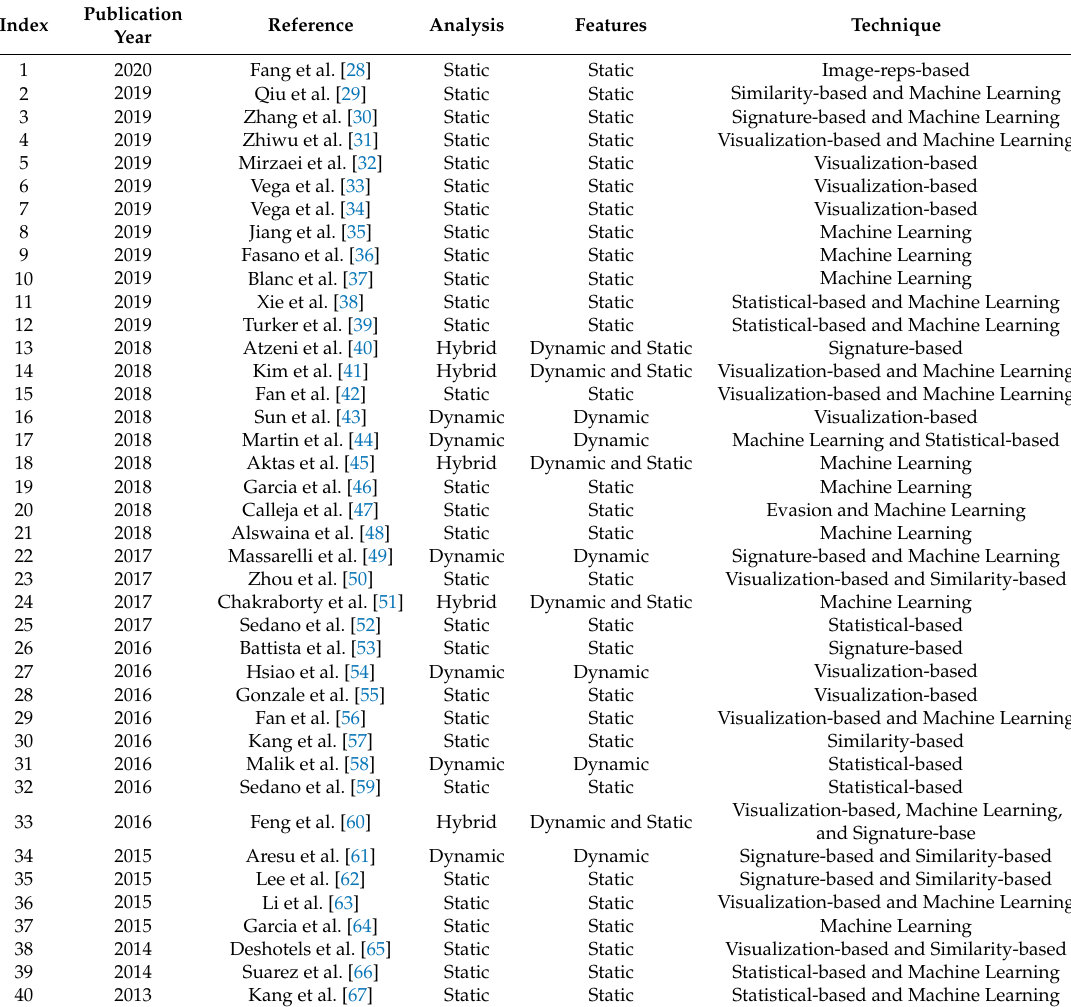
Table 1. Taxonomy table of the